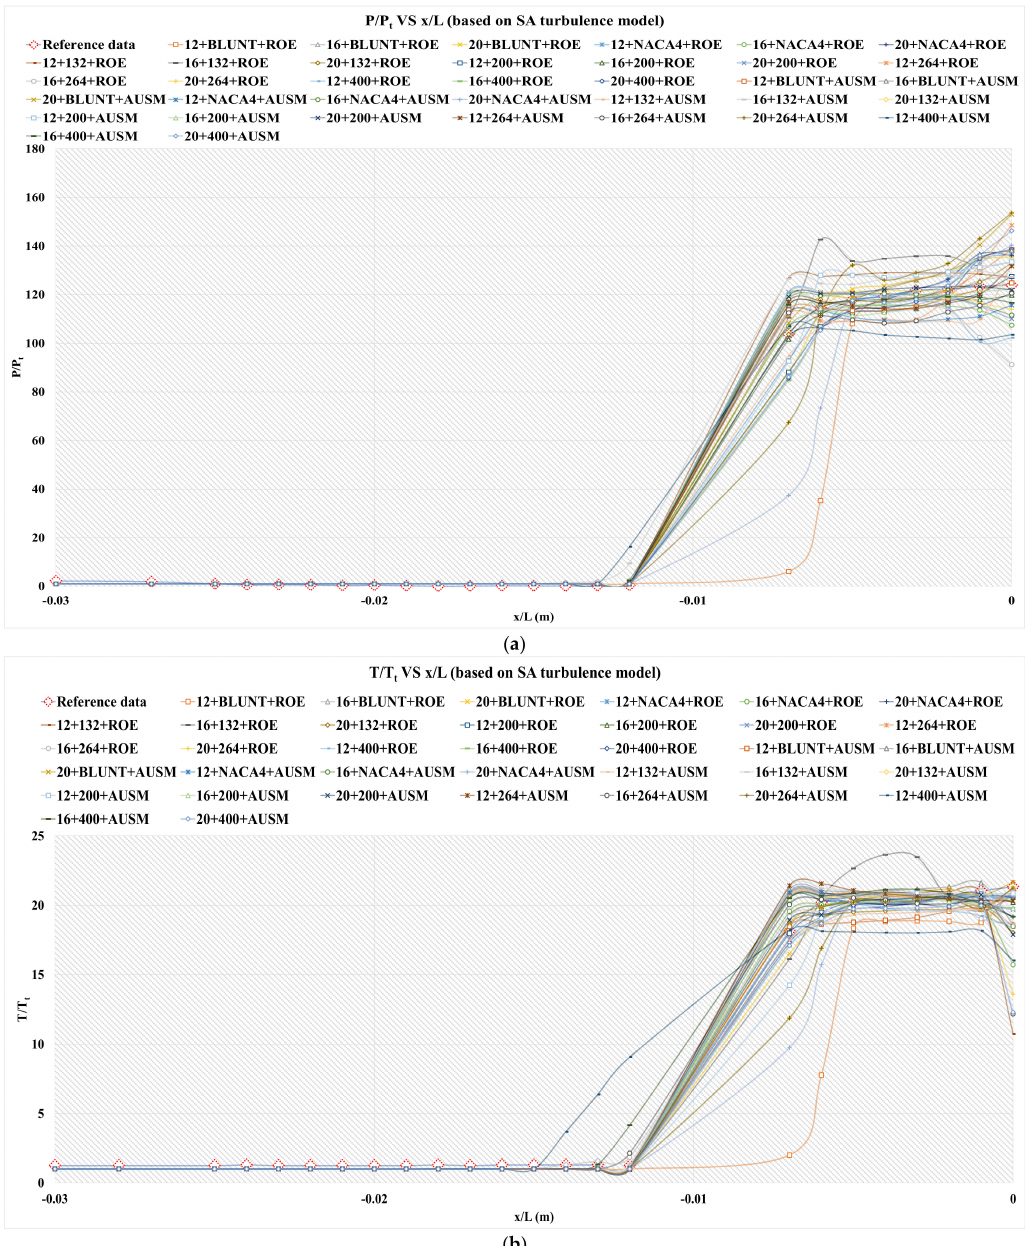
Figure 31. ( a ) Distributions of P/P t of SA turbulence model; ( b ) Distributions of T/T t of SA turbulence